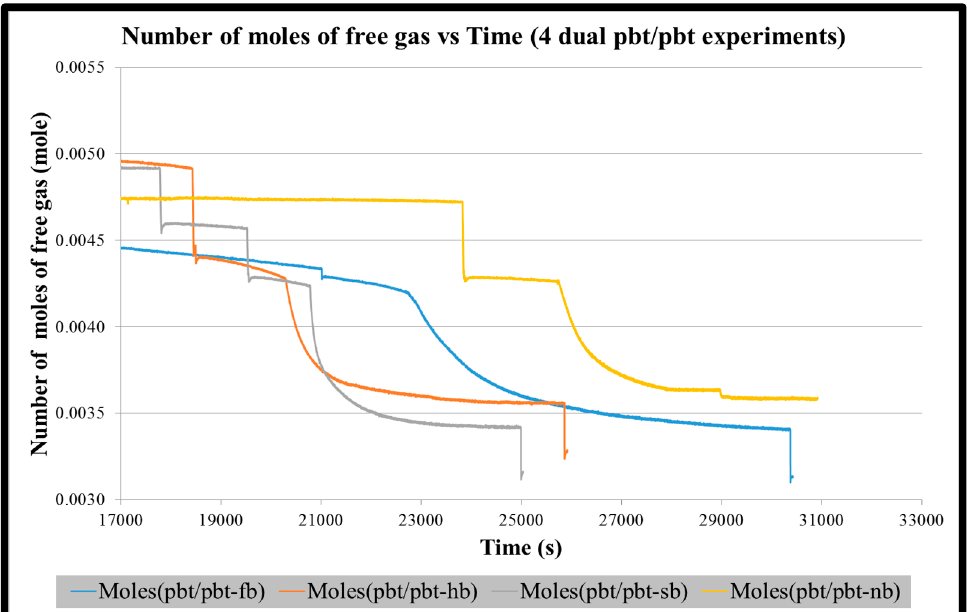
start of stabilization of hydrate formation .